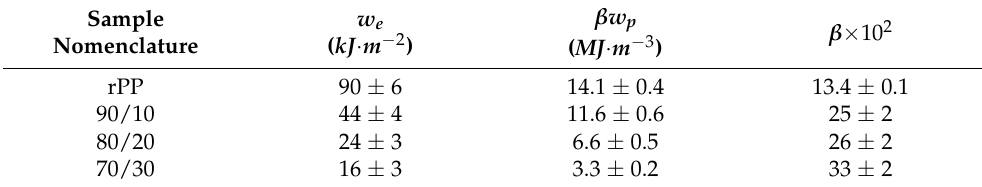
Table 4. Total EWF parameters of rPP/rPET-O calendered sheets tested at 10 mm · min − 1 .